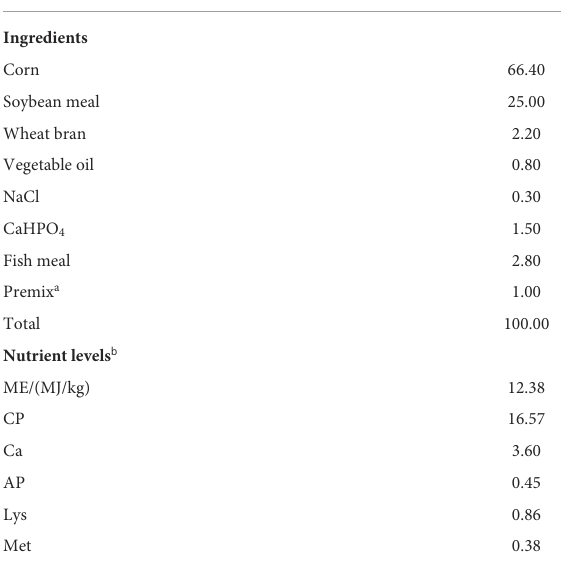
TABLE 1 Ingredients and chemical composition of basal diet. Items